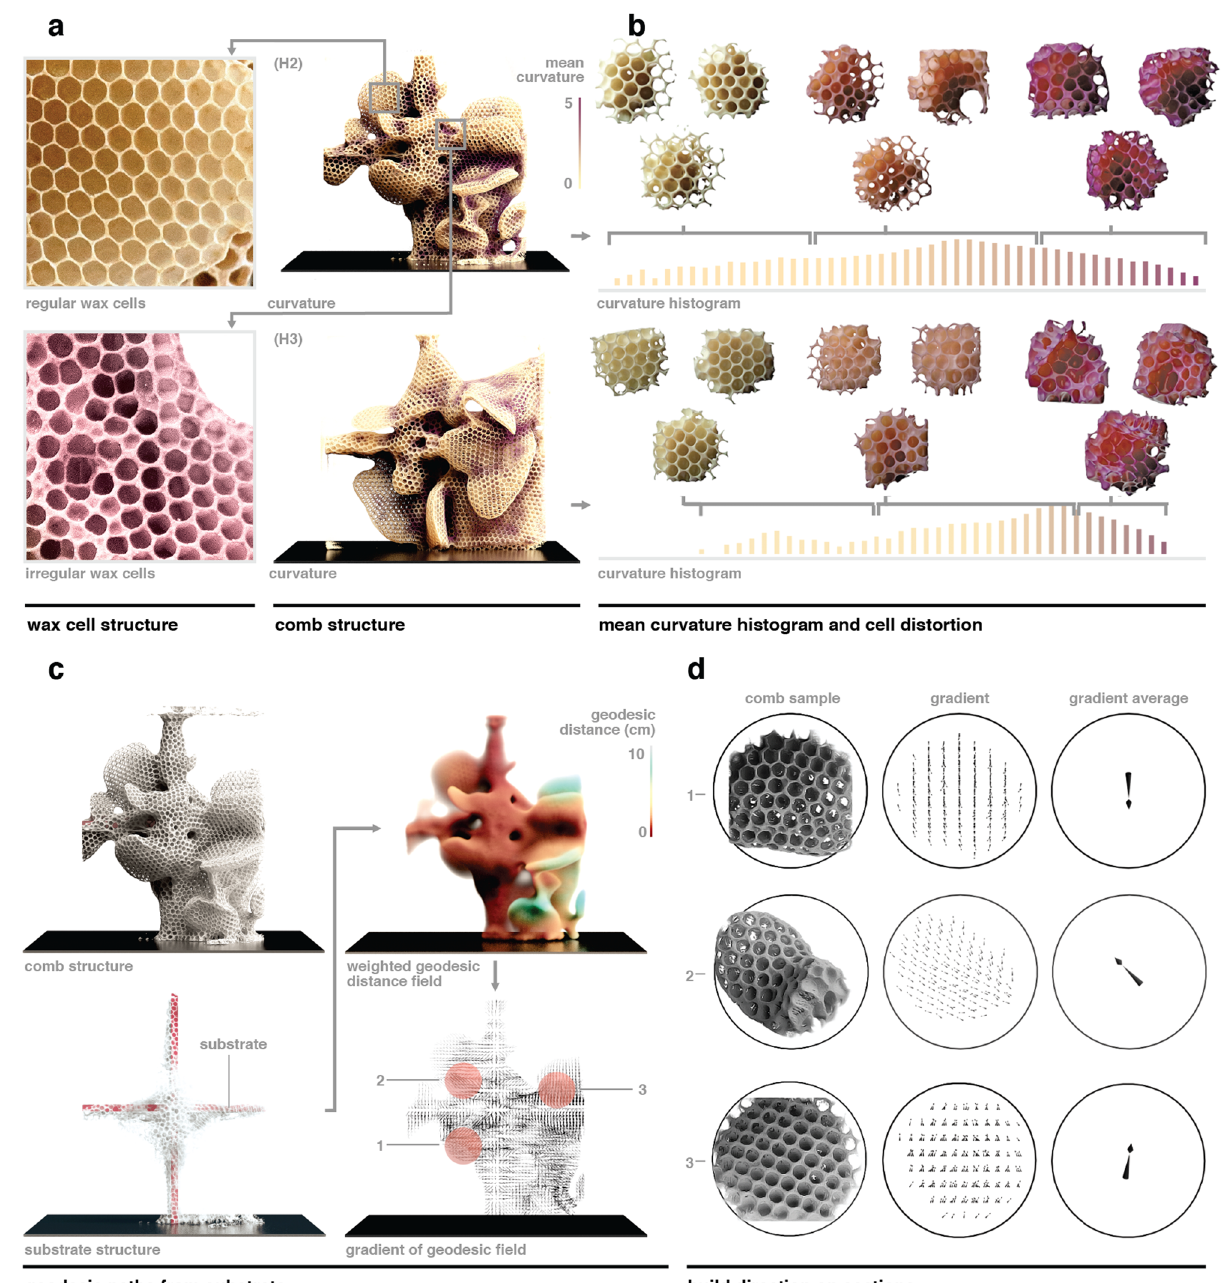
Fig. 4 Digitally driven observations of cell regularity and build direction. a Visually identi fi ed examples of regular (upper) and irregular (lower) cells within a comb digital reconstruction. b The relationship between comb curvature and irregular cell construction is analyzed for the comb architectures of two experimental cubes (Hives 2 and 3). Using the established Gaussian curvature tool, the combs are color-coded according to their principal curvature κ κ 1 , distinguishing high curvatures (violet) and low curvatures (yellow). Curvature histograms of 1 are shown for each of the hives, displaying the distribution of curvature across the combs, and their corresponding color-coded images illustrate the extent of local cell distortion. c Comb build direction is compared to the gradient of the distance fi eld from the initial underlying substrate. For the Hive 2 comb, the geodesic distance fi eld is color-coded (red to blue) by increasing distance from the initial underlying substrate (top-right), and its gradient is shown as a vector fi eld (bottom-right). Three sample regions of interest were selected for further analysis. d For each sample region, visualized (left), the gradients of the geodesic fi eld over the region are displayed (middle), and the average of these gradients is calculated (right). The resulting vector corresponds to the bees ’ build direction, as identi fi ed by Pratt ’ s method using one vertex of each cell oriented such that it points toward the